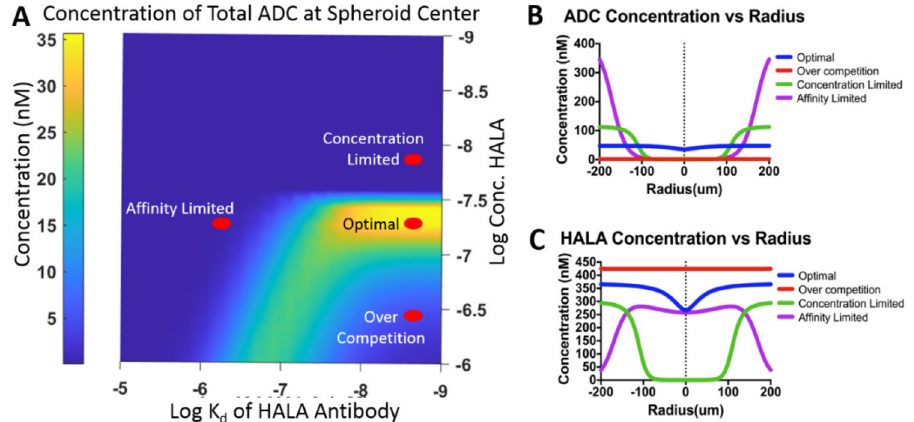
Figure 3. Simulating ADC distribution in spheroids. ( A ) Spheroid model simulating the concentration of ADC binding at the center of the spheroid. Both the affinity of the HALA antibody and the concentration of HALA antibody were varied. As the affinity of the HALA antibody is reduced, higher concentrations of HALA antibody are required to maintain competition and drive ADC to the spheroid center. Concentration of the ADC binding ( B ) or HALA antibody binding ( C ) over varying distances within the